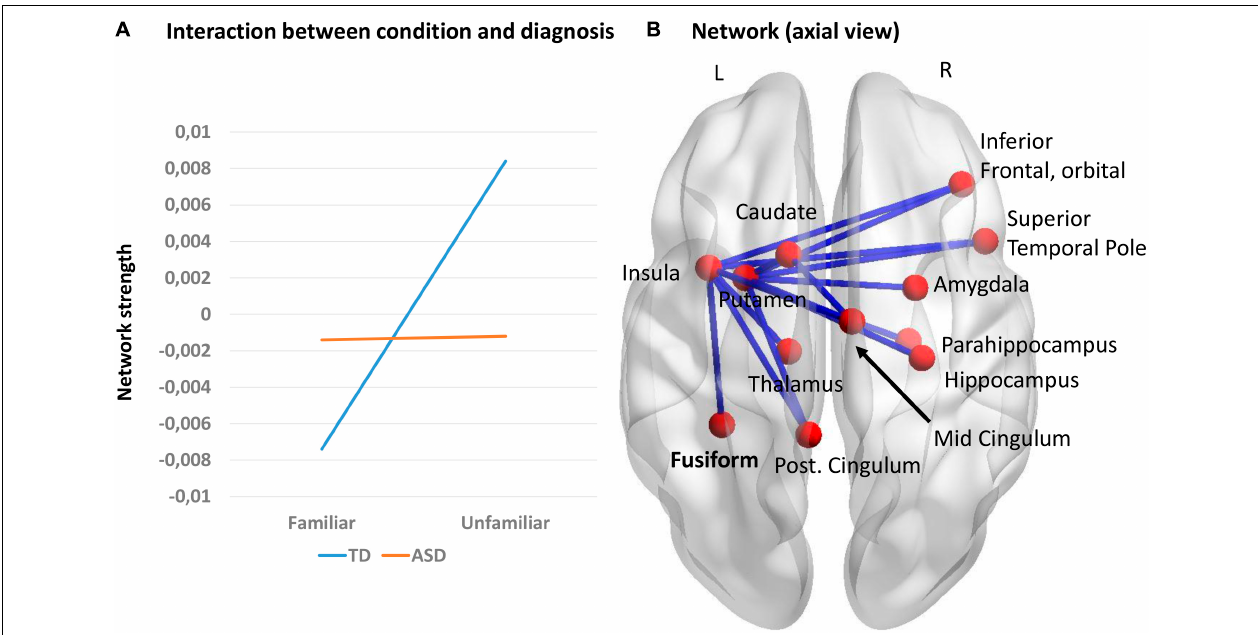
FIGURE 4 | (A) Interaction effects between music condition and group; (B) Network representing the significant interaction in the alpha frequency band, using the wPLI metric ( p =